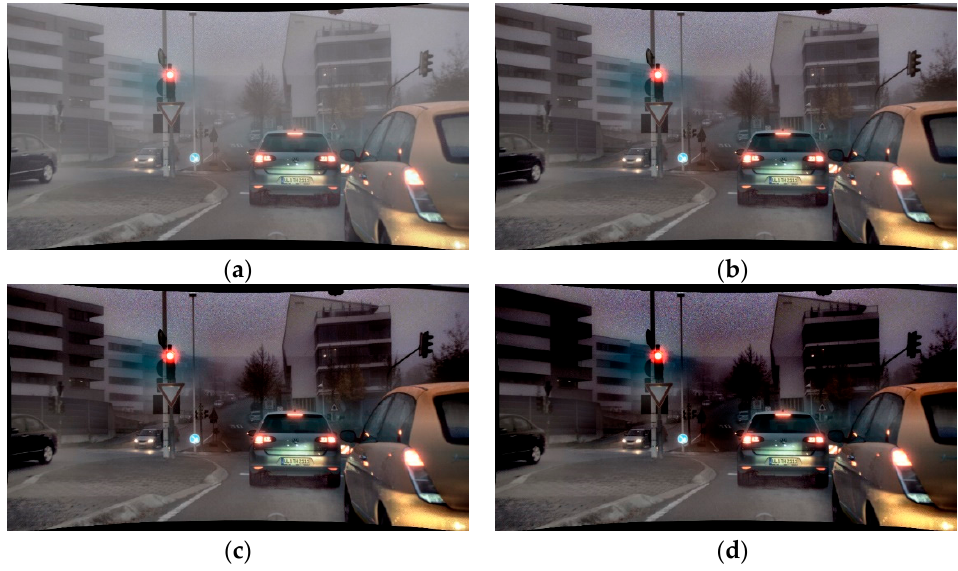
Figure 13. Dehazed results at various background parameters: ( a ) hazy input; ( b ) 120; ( c ) 195; ( d )